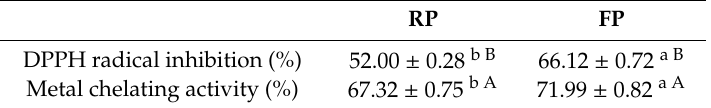
Table 2. Antioxidant activities of raw and fermented pepper